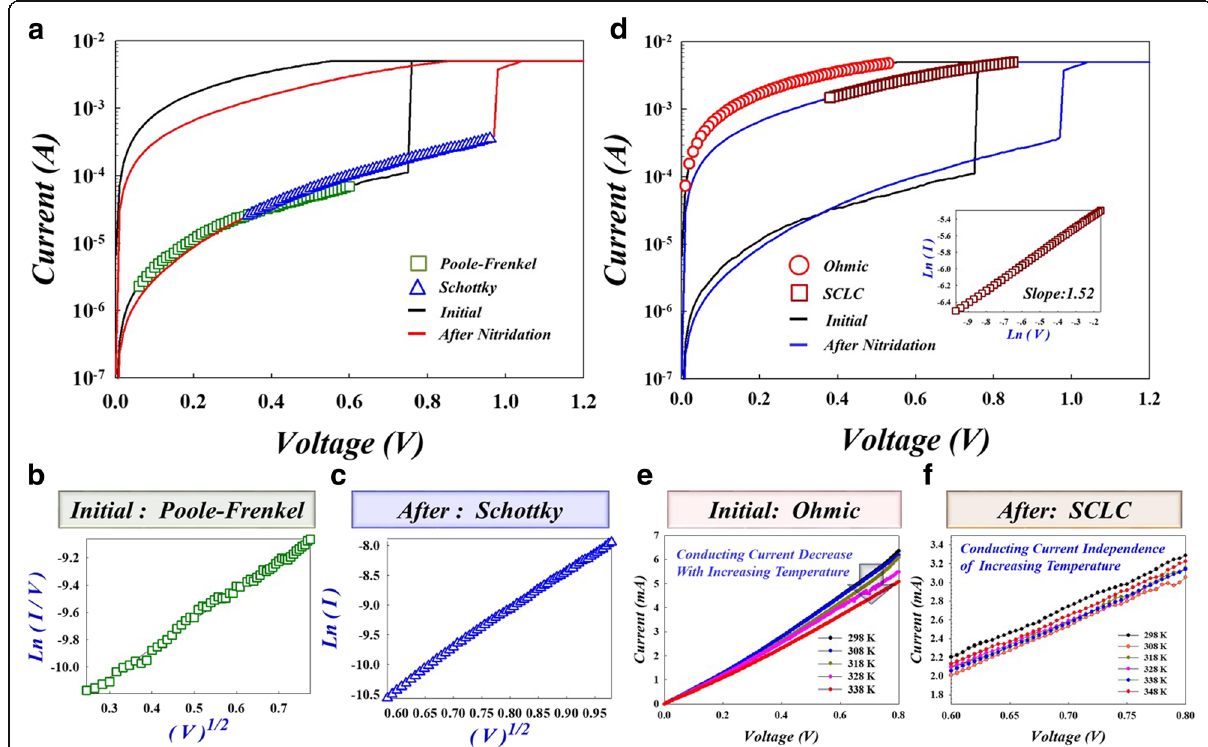
Fig. 4 a Analysis current conduction mechanism of HRS from I-V curves in HfO 2 -based RRAM between initial and after nitridation treatment. b The Poole-Frenkel current conduction mechanism of HRS in HfO 2 -based RRAM. c The Schottky emission current conduction mechanism of HRS in HfO 2 -based RRAM after the nitridation treatment. d Analysis current conduction mechanism of LRS which transforms to SCLC from ohmic conduction after nitridation treatment in HfO 2 -based RRAM; the inset figure shows the SCLC current fitting result. e The Ohmic conduction mechanism of LRS in HfO 2 -based RRAM which is characteristic in current negative correlation with temperature. f The SCLC mechanism of LRS in HfO 2 -based RRAM that is independent on temperature after the nitridation treatment